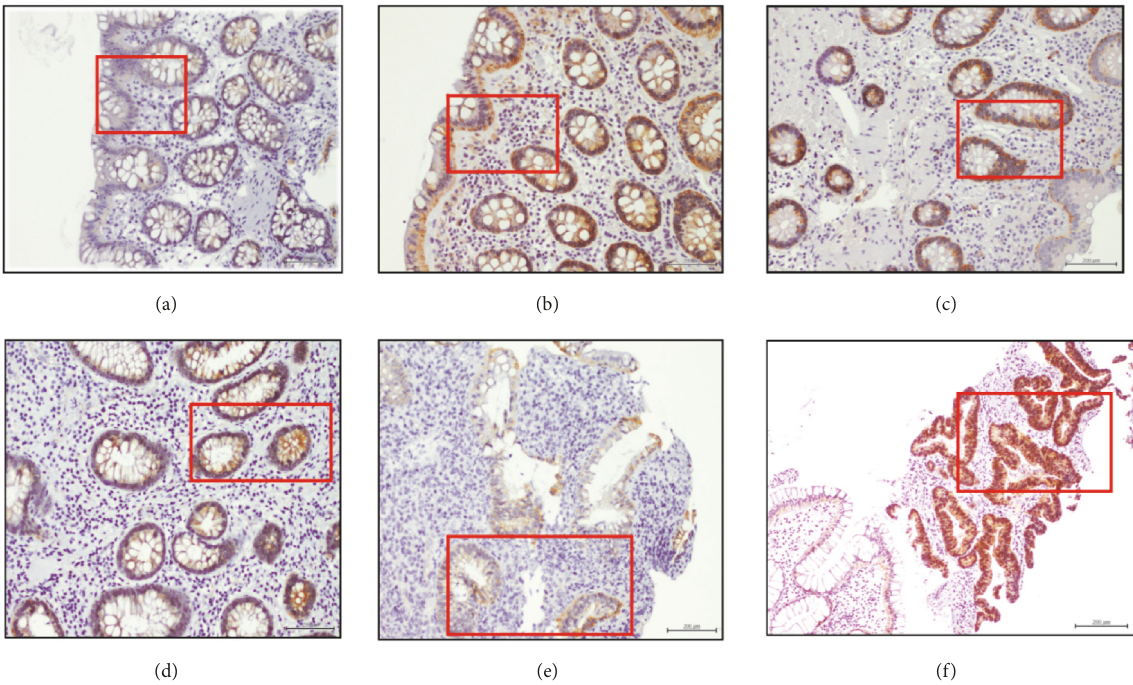
Figure 2: Nuclearand membrane/cytoplasmic 𝛽 -cateninimmunoexpression for 122 patients. (a) Normal group (n=25). (b) C-IBS (n=30). (c) D-IBS (n=15). (d) CD (n=7). (e) UC (n=12). (f) CRC (n=33). Significant increase 𝛽 -catenin protein expression from Normal group to CRC, especially nuclear localization. Magnification x40. Scale bar = 200 𝜇 m.